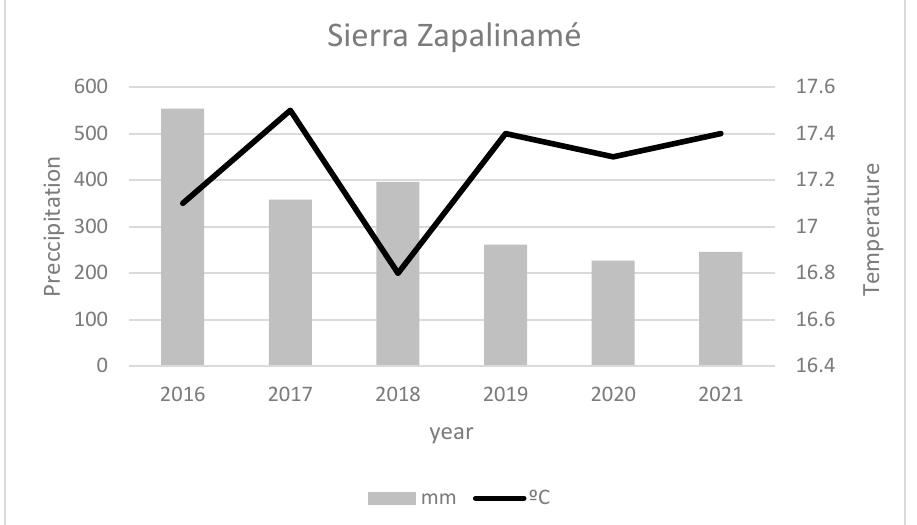
Figure 2. Average annual precipitation and average annual temperature in the area of Sierra Zapalinamé throughout the years of the study.